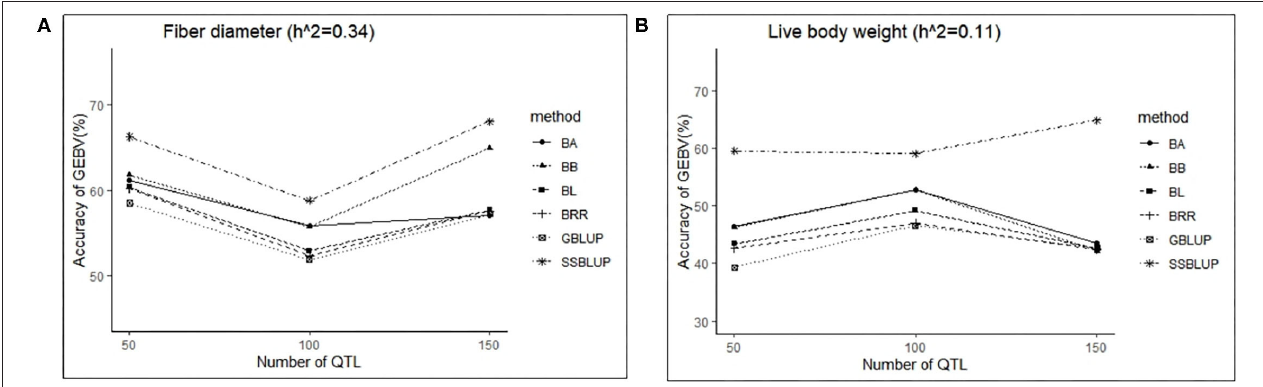
FIGURE 4 | The change trends of accuracy of GEBV with increasing number of QTLs with GBLUP and Bayes methods.